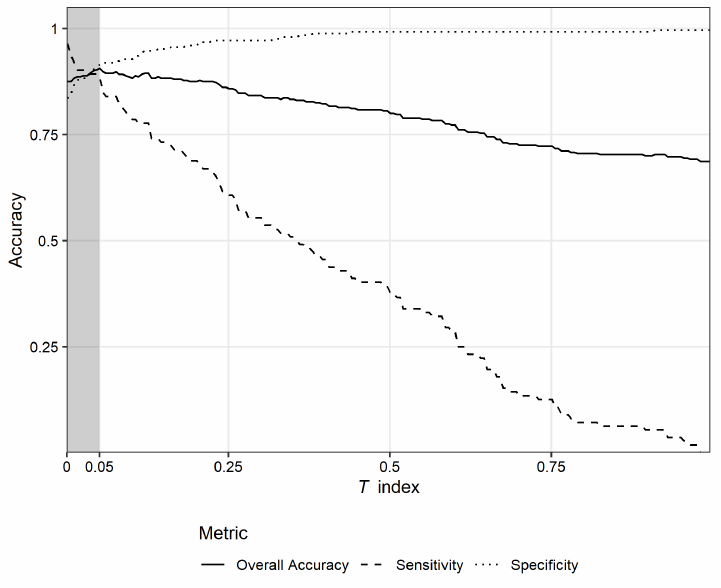
Figure 5. Ability of the T index to accurately identify representative (random) hold-out sets. Results validate the proposed nomenclature to interpret the T